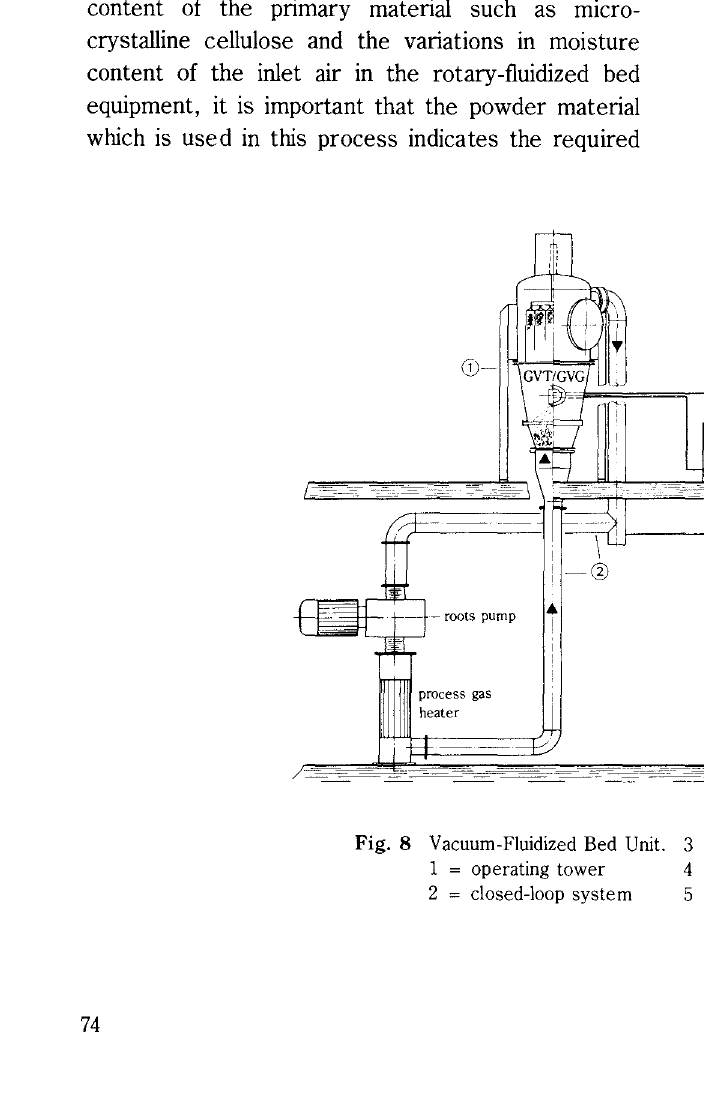
Fig. 8 Vacuum-Fluidized Bed Unit. 3 = solvent recovery system 1 = operating